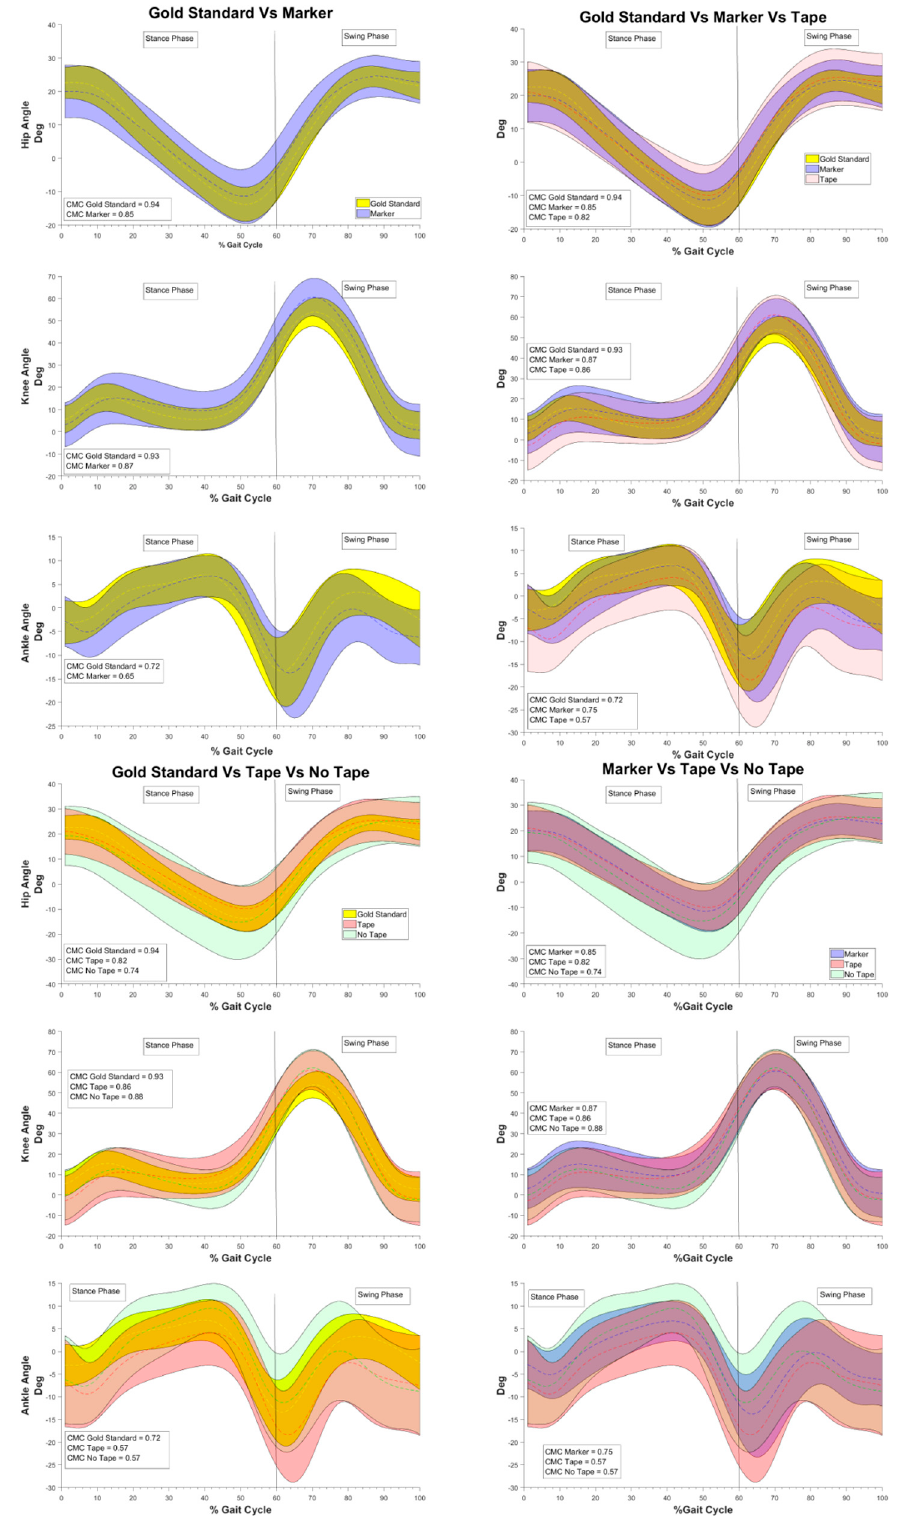
Figure 2. The hip, knee and ankle sagittal plane angles (mean ± SD), for each comparison between the set ups, are represented. The CMC, for each set up, is reported. The set ups are represented as follows: in yellow the “Gold Standard”, in blue “Marker”, in red “Tape” and in green “No Tape”.